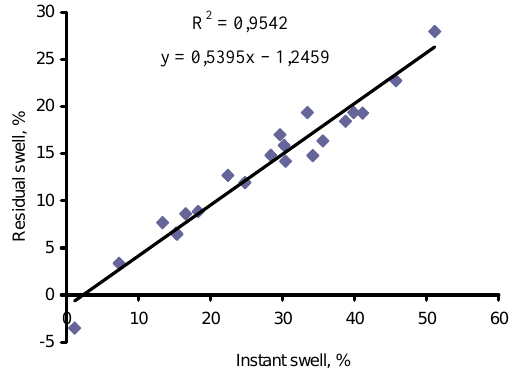
Fig. 8. Correlation between the instant and residual swell of hot- pressed board samples